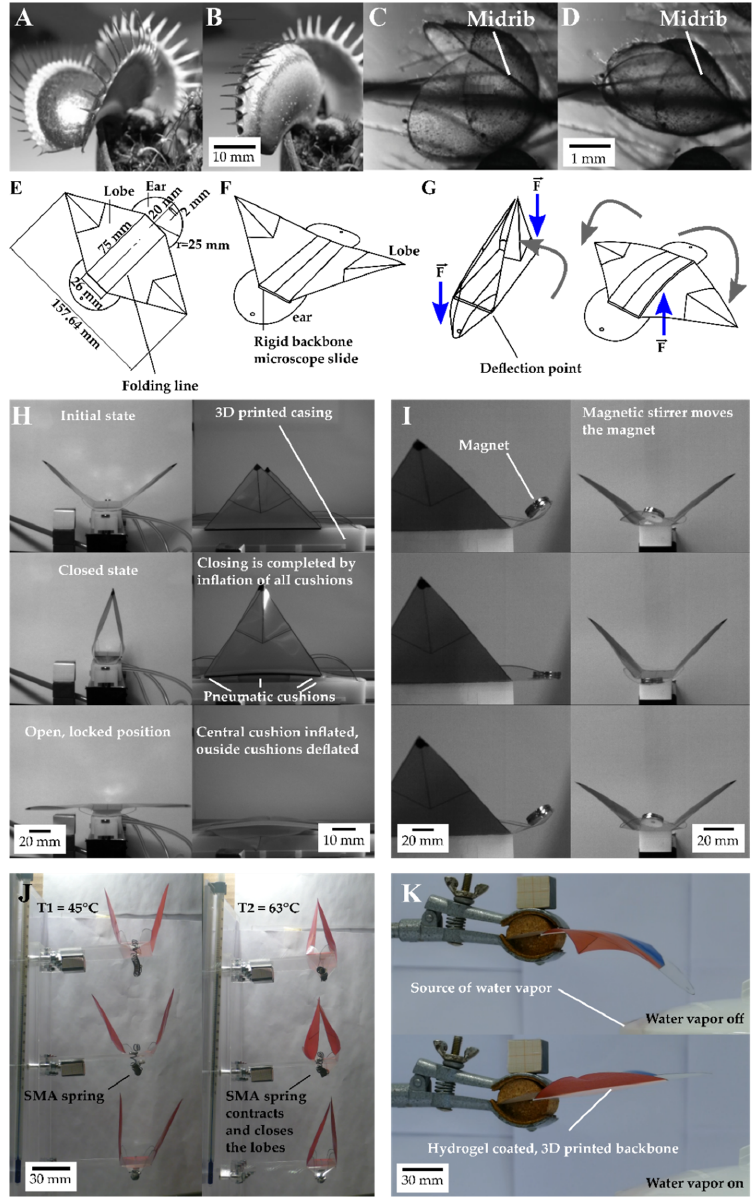
Figure 1. After being triggered, the Venus flytrap ( Dionaea muscipula ) closes its lobes by inverting the curvature of the lobes from, as viewed from the outside, concave ( A ) to convex ( B ) through the release of stored elastic energy. In the waterwheel plant ( Aldrovanda vesiculosa ) ( C ), water displacement in turgescent cells lying along the midrib combined with the release of stored elastic energy results in bending of the midrib, which is kinematical amplified and causes trap closure ( D ). The compliant foil demonstrator, the Venus Flyflap (VFf) ( E ), combines both mechanisms to close and open its artificial lobes. When force is applied to the ears ( F , G ), the lobes close via a kinematic coupling mechanism. Force applied to the backbone triggers a fast-snapping opening movement similar to the closing movement of the Venus flytrap. These mechanisms have been incorporated into various actuation scenarios. Pneumatic cushions drive the motion and enable the characterization of each phase of the motion sequence ( H ). A resonance-like, rapidly oscillating, flapping motion is achieved by a magnet that is attached to the ears and that responds to a rotating magnetic field ( I ). The VFf can also be actuated by environmental stimuli, when fitted with shape memory alloy (SMA) springs ( J ) or a combination of environmentally sensitive materials such as SMA and polymers in combination with hydrogels reacting only to a change in humidity and temperature ( K